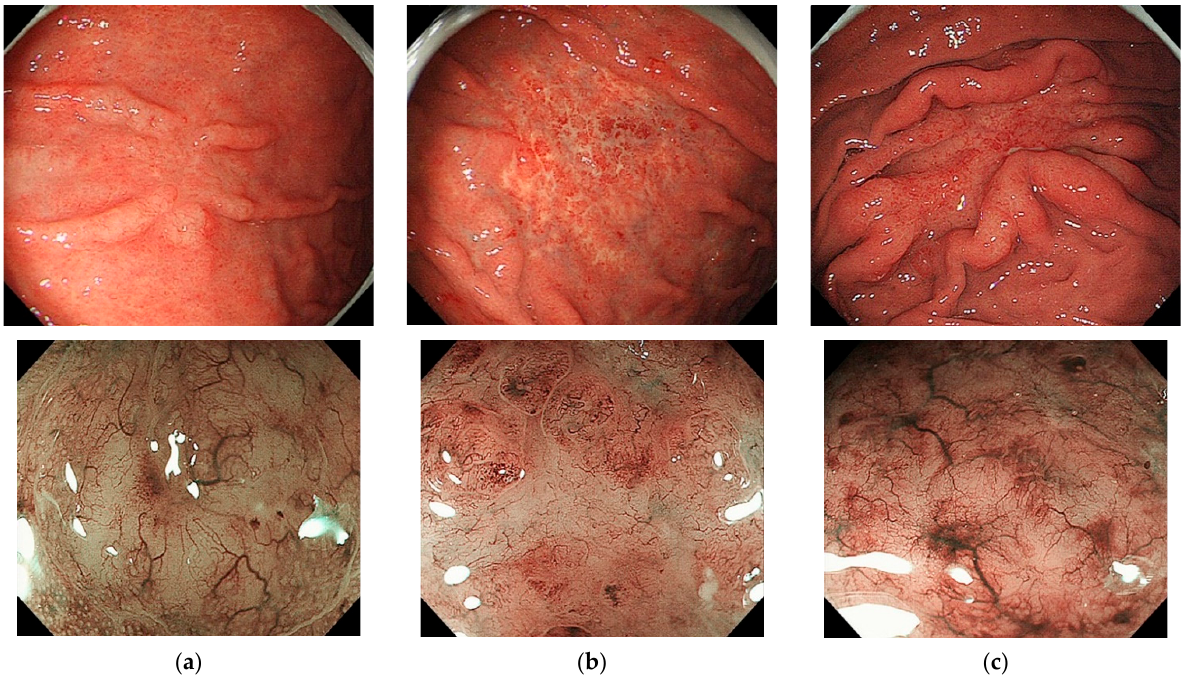
Figure 1. Endoscopic findings of superficial-type gastric MALT lymphomas in three patients (from author’s original research). The upper three photos are conventional endoscopic images and lower three photos are magnified endoscopic images showing a characteristic tree-like appearance with whitish, amorphous areas. ( a ) Patient 1, ( b ) Patient 2, and ( c ) Patient